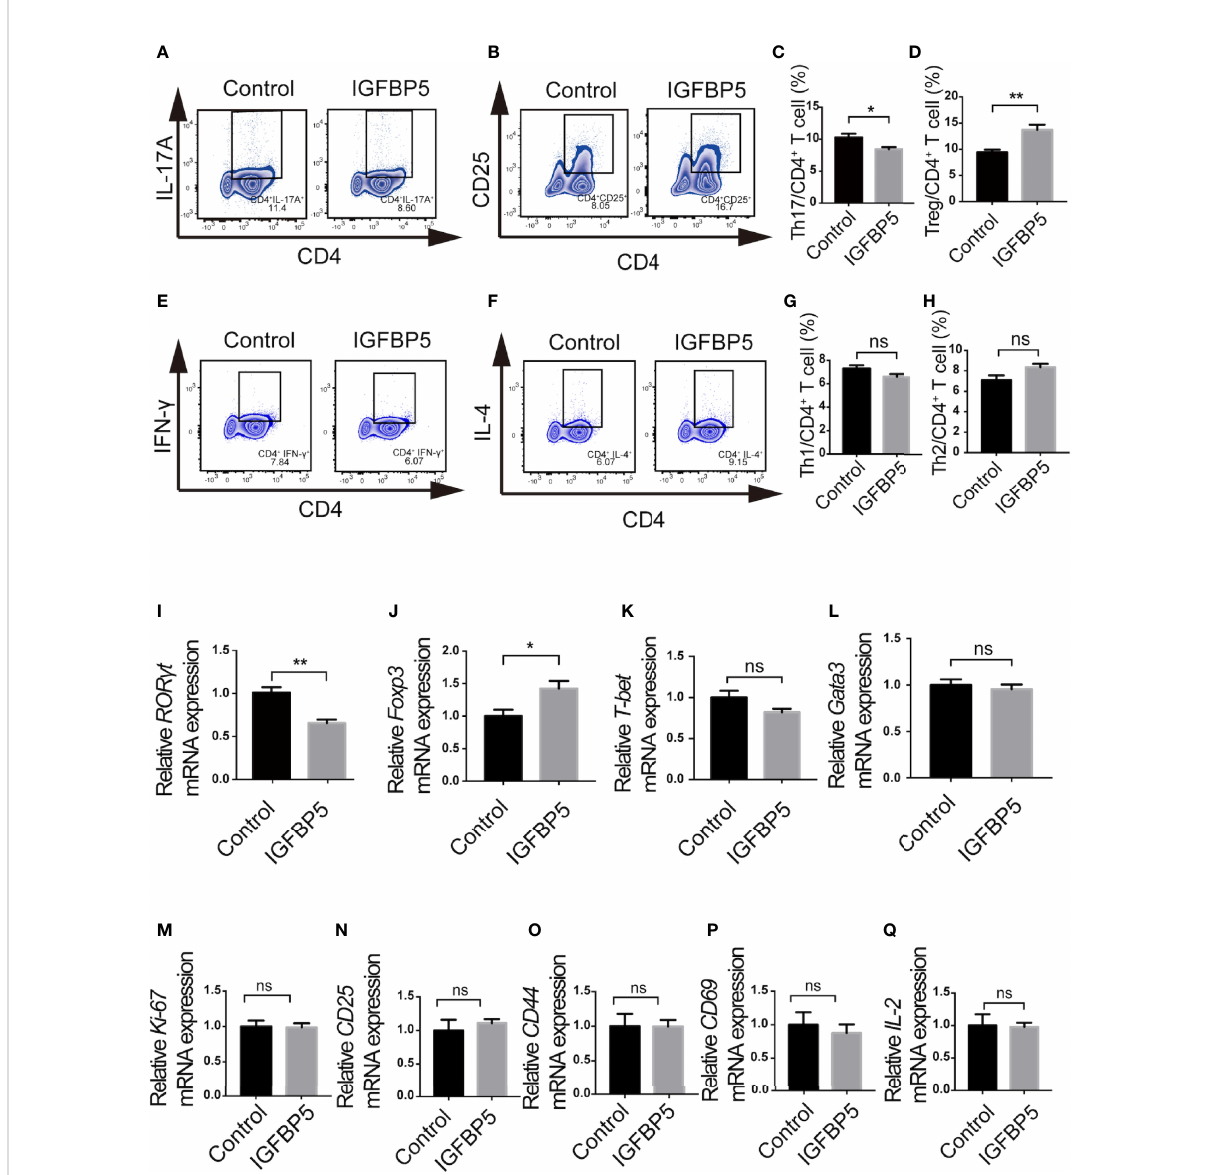
FIGURE 1 IGFBP5 increased the percentage of Treg cells and decreased the percentage of Th17 cells. Flow cytometry and RT-qPCR were used to detect the effect of IGFBP5 on T cell subsets in vitro . (A, C) Flow cytometry showed that the percentage of CD4 + IL-17A + Th17 cells in the CD3/CD28 activated T cells decreased after the treatment of recombinant IGFBP5. (B, D) Flow cytometry showed that the percentage of CD4 + CD25 + Treg cells in the CD3/CD28 activated T cells increased after IGFBP5 treatment. (E, G) Flow cytometry showed that the percentage of CD4 + IFN- g + Th1 cells in the CD3/CD28 activated T cells decreased slightly after the treatment of recombinant IGFBP5. (F, H) Flow cytometry showed that the percentage of CD4 + IL-4 + Th2 cells in the CD3/CD28 activated T cells increased slightly after IGFBP5 treatment. (I, J) RT-qPCR showed that the expression of ROR g t was signi fi cantly reduced and the expression of Foxp3 was markedly increased in IGFBP5 group. (K, L) RT-qPCR showed that the expression of T-bet was slightly reduced and there was little effect on the expression of Gata3 after the treatment of IGFBP5. (M-Q) The relative mRNA levels of Ki-67 and activation-related CD25 , CD44 , CD69 and IL-2 . Student ’ s t-test was used to determine statistical signi fi cance. The data are presented as the mean ± SEM (n=3). The experiment was repeated three times independently. * p < 0.05, ** p < 0.01; ns, not signi fi